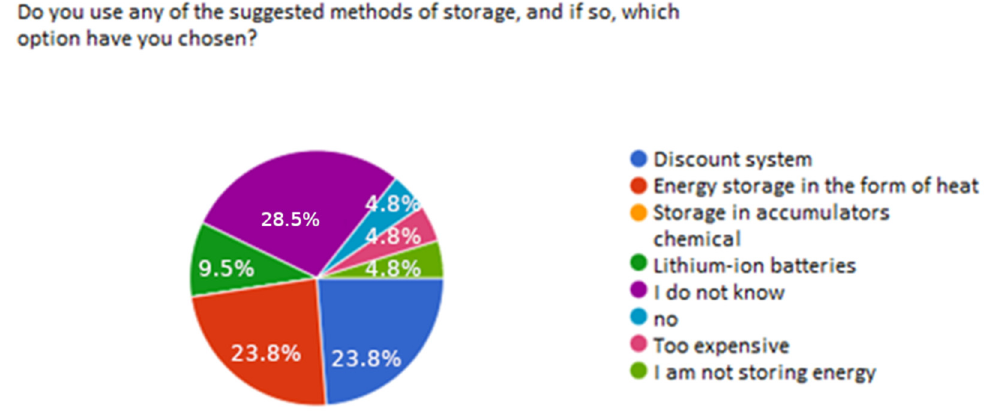
Figure 15. Reasons for giving up energy storage.